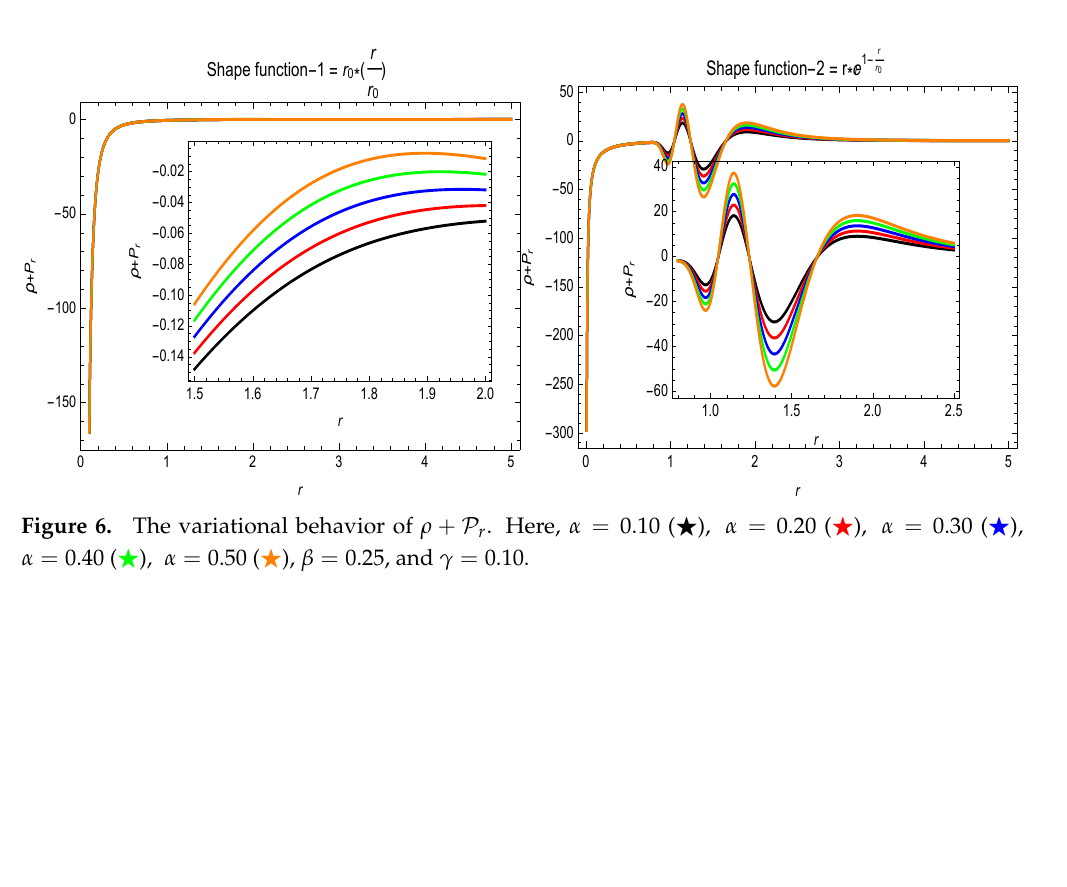
Figure 5. The variational behavior of ρ . Here, α = 0.10 ( (cid:70) ), α = 0.20 ( (cid:70) ), α = 0.30 ( (cid:70) ), α = 0.40 ( (cid:70) ), α = 0.50 ( (cid:70) ), β = 0.25, and γ = 0.10.